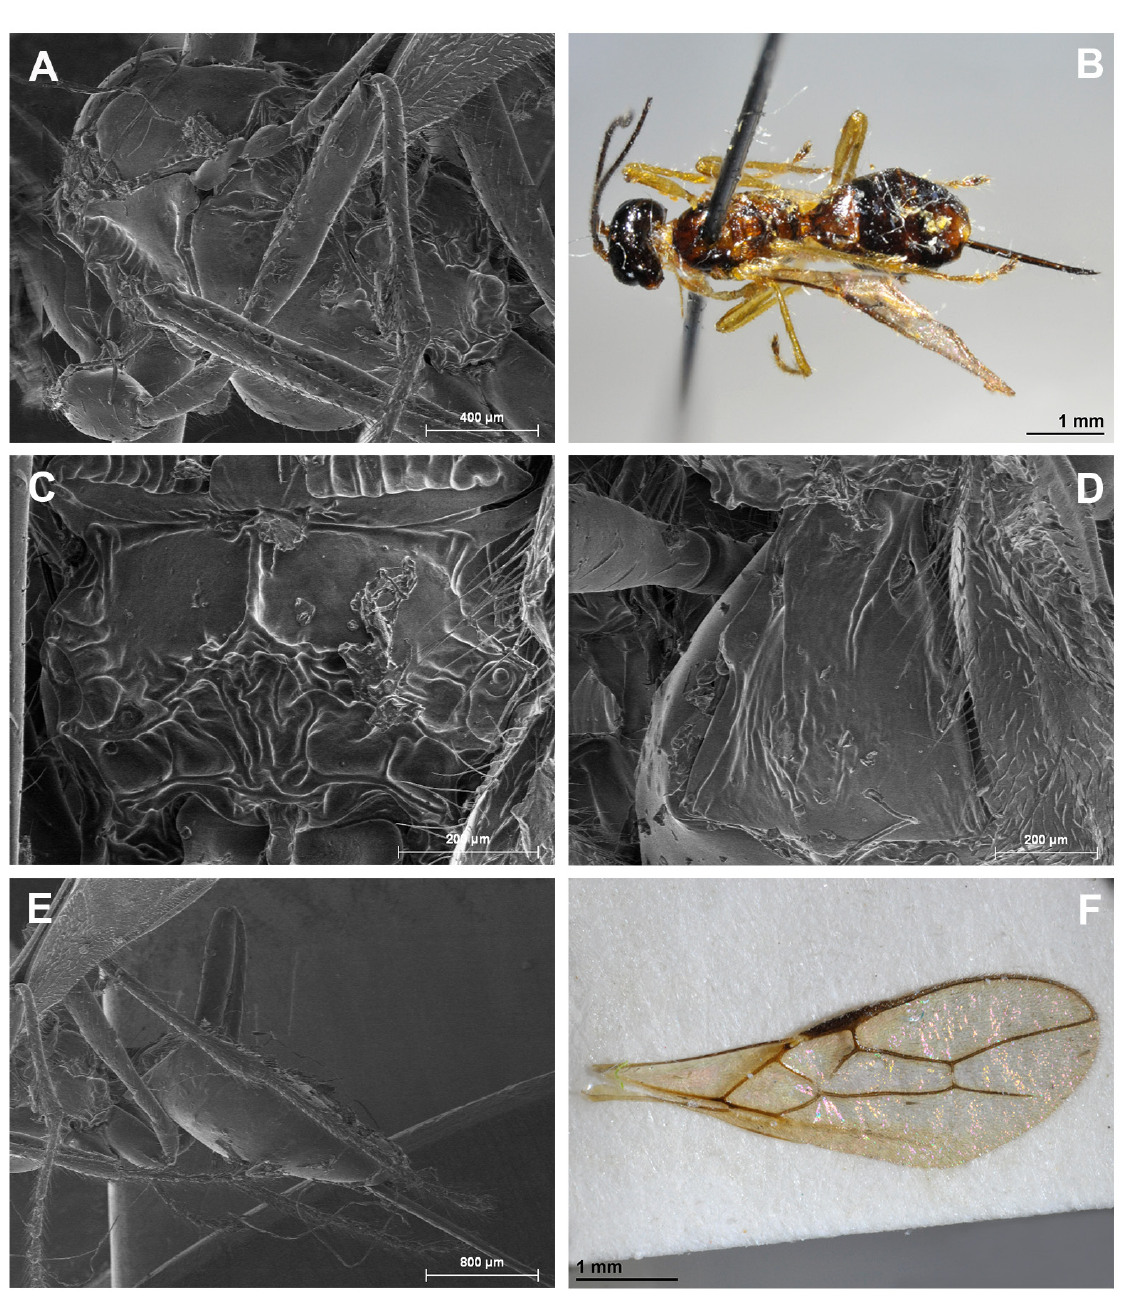
Fig. 69. Asobara ugandensis Fischer, 2007, ♀, holotype (OLML). A . Mesosoma, lateral view. B . Habitus, dorsal view. C . Propodeum. D . First metasomal tergite, dorsal view. E . Hind leg, metasoma and ovipositor, lateral view. F . Fore